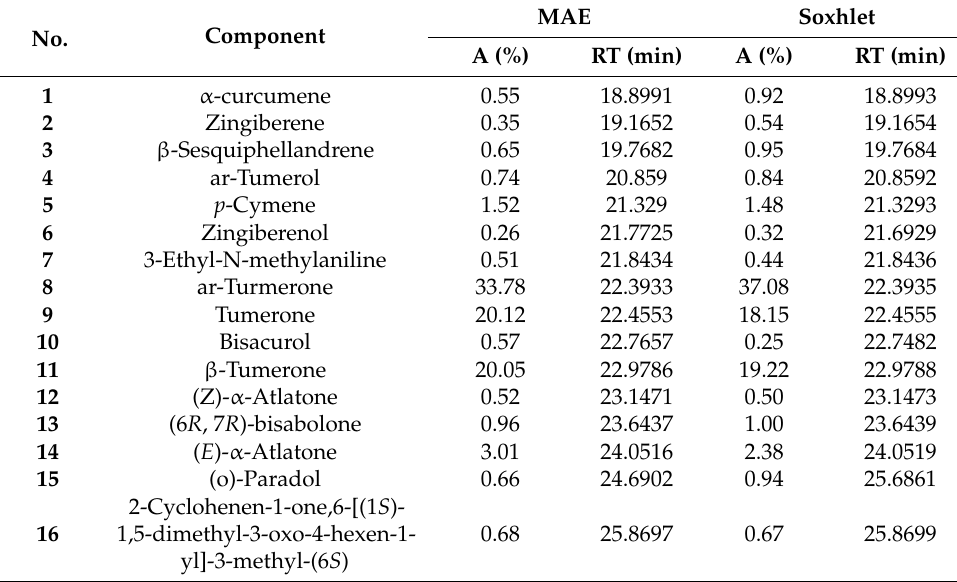
Table 4. Curcuma longa L. oil composition evaluated by GC/MS.